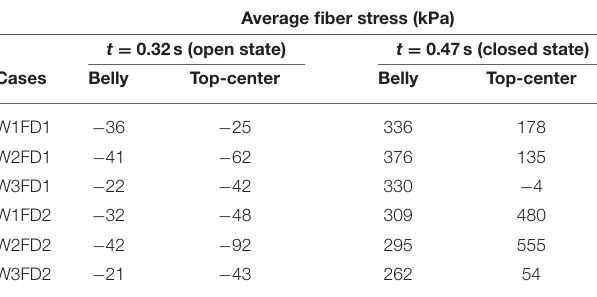
TABLE 6 | Average fiber stress at the belly and